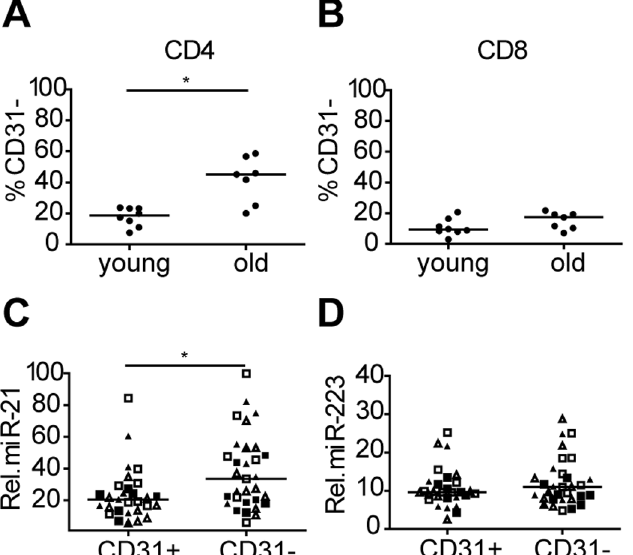
Fig 3. MiR-21 is upregulated in CD31- T cells in the CD45RO- compartment. Percentage of CD31+ and CD31- in (A) CD4+CD45RO- and (B) CD4-CD45RO- T cells in young and old donors. Relative expression of (C) miR-21 and (D) miR-223 in CD31-and CD31+ T-cell subset sorted from the CD45RO- T-cell compartment. MiRNA expression was normalized to the expression of RNU49 (line indicates median). Squares indicate cells from young and triangles indicate cells from old donors. Filled symbols indicate CD4 + T cells and open symbols indicate CD8+ T cells. * p (cid:1) 0.05.